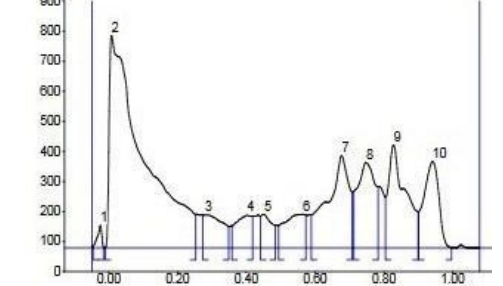
Fig. 20. Reflux - hexane fruit